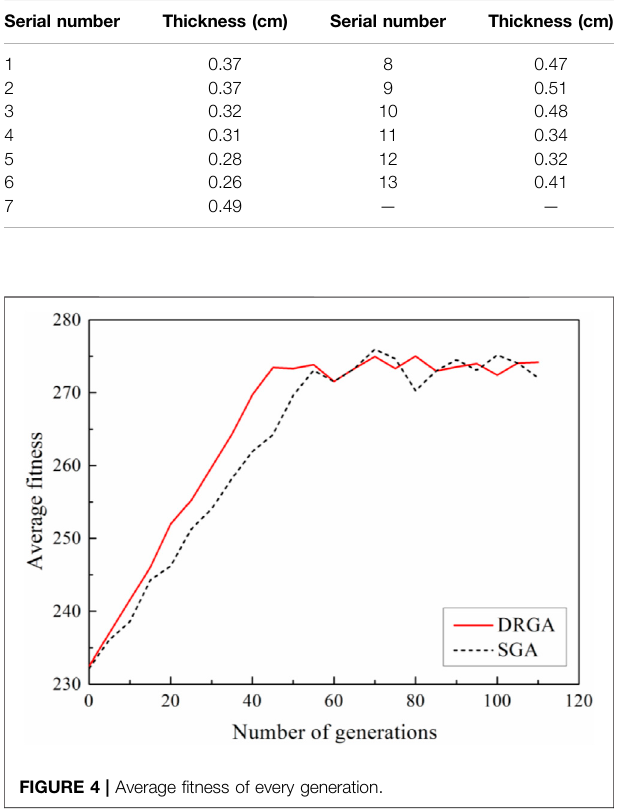
FIGURE 4 | Average fi tness of every